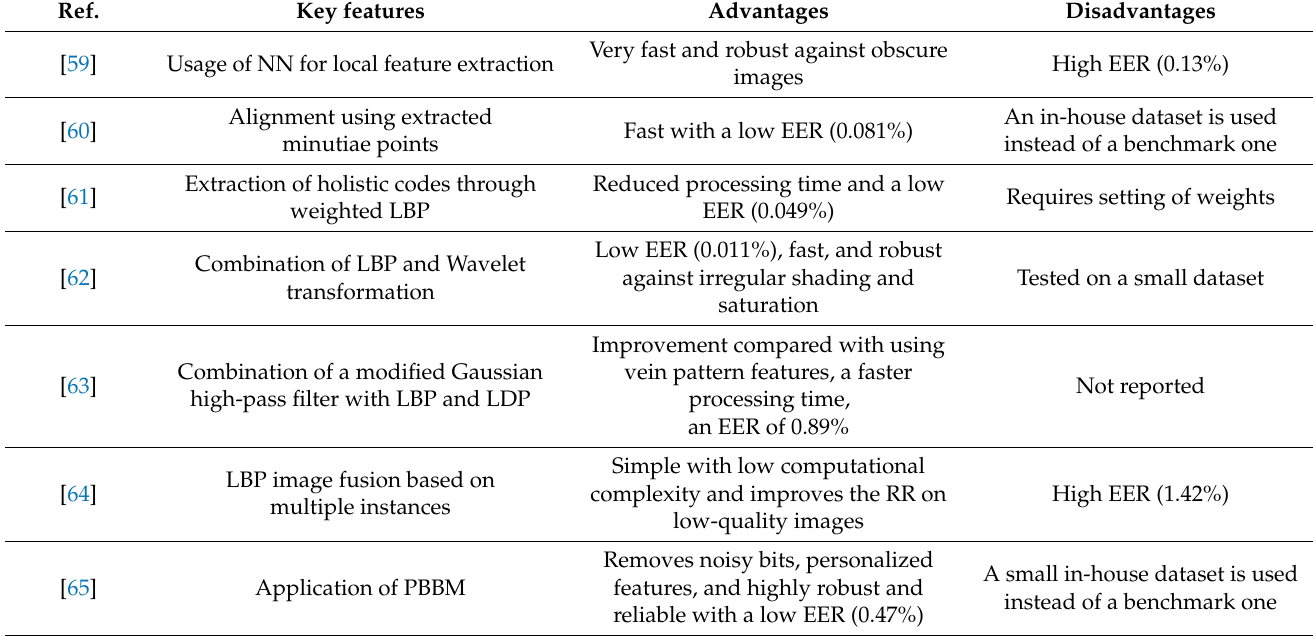
Table 3. Characteristics of the local binary pattern-based feature extraction methodologies.